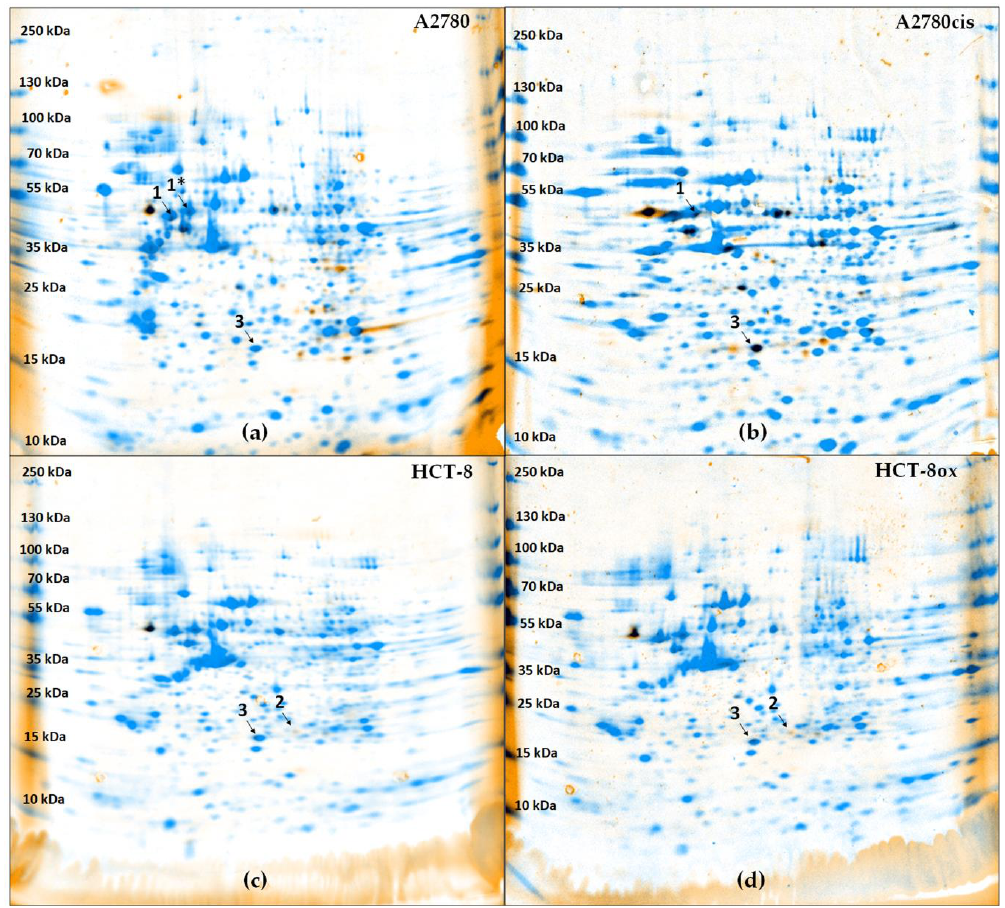
Figure 2. Overlay of fluorescence image and protein staining (Coomassie) in gels after two-dimensional electrophoresis (pH 3–10 NL) of each 20 µg cytosolic fraction of ( a ) A2780, ( b ) A2780cis, ( c ) HCT-8, and ( d ) HCT-8ox cells treated with BODIPY-cisplatin. Spots 1 and 1* were identified as vimentin, spot 2 as Grb2, and spot 3 as GSTP1.